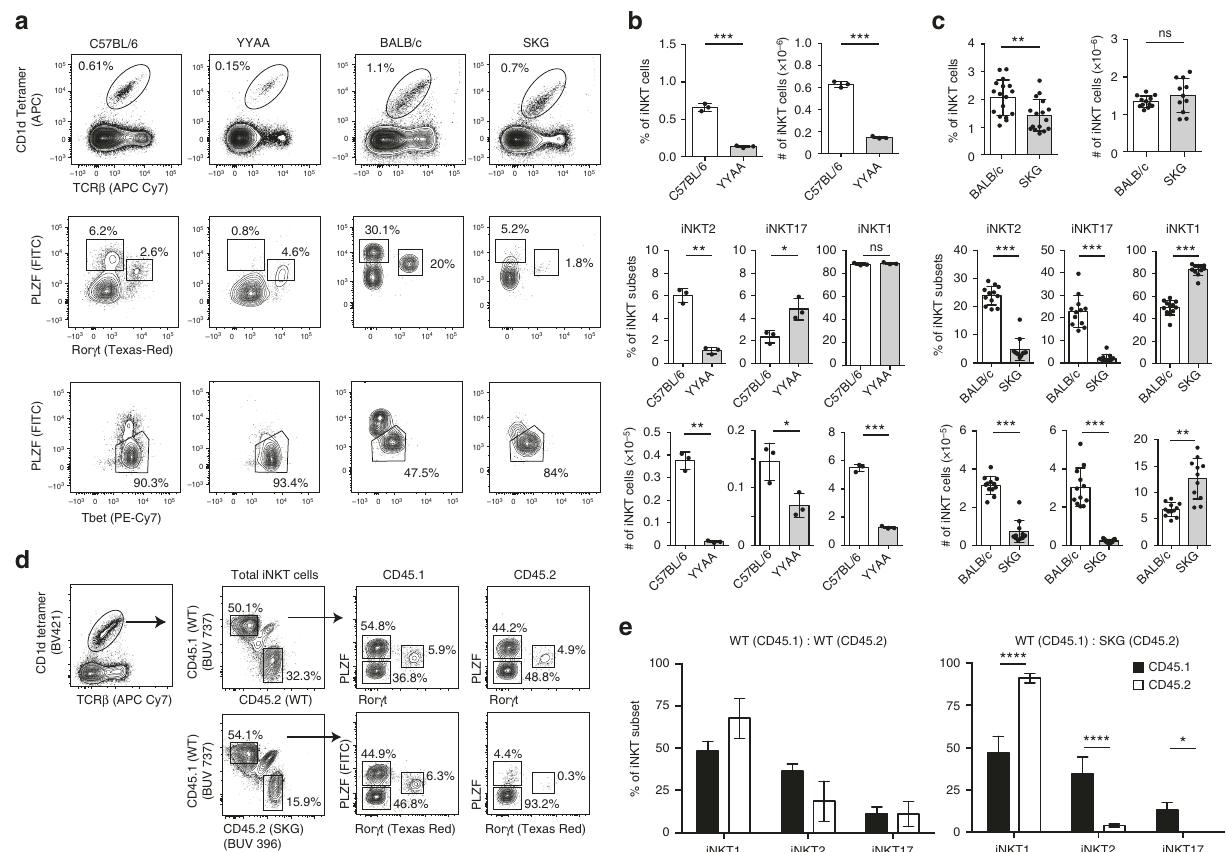
Fig. 4 Cell-intrinsic de fi ciency in iNKT2 and iNKT17 subsets development in mice with Zap70 hypomorphic mutations. a Representative fl ow cytometry plots showing the frequency of total iNKT cells and iNKT cell subsets in the thymi of 8-week-old C57BL/6, C57BL/6 YYAA, BALB/c, and BALB/c SKG mice. Each genotype was analyzed independently and compared to wild-type control mice of the appropriate background. b , c Summary of the data shown in a with percentages and cell numbers of total iNKT cells and iNKT cell subsets in the various genotypes analyzed. Data are mean ± SD. Signi fi cance was assessed using the unpaired t -test. d Analysis of thymic iNKT cell subsets in competitive bone marrow chimera. Congenically marked bone marrow cells from BALB/c wild-type mice (CD45.1) were mixed in a 1:1 ratio with (CD45.2) BALB/c or SKG bone marrow cells and injected into lethally irradiated F1 (CD45.2 × CD45.1) BALB/c mice. The thymi of the chimera were analyzed for iNKT cell subset composition 8 – 10 weeks post reconstitution and representative fl ow cytometry plots are shown. After gating on total iNKT cells, the proportion of iNKT cell subsets derived from either CD45.2 + or CD45.1 + bone marrow cells is shown. e Summary of the data shown in d with ≥ 5 mice per group. Data are represented as mean ± SD. Signi fi cance was assessed using one-way analysis of variance (ANOVA) * p < 0.05; ** p < 0.01; *** p < 0.001; **** p < 0.0001; ns, not signi fi ( Ifn γ , Tbx21 , Cxcr3 , Ccr5 , Il2rb , Fasl , Bcl2 , Il2 , Zbtb16 , Slamf6 , Il17rb , Il6ra , Ccr7 ) is different between subsets (Supplementary Figs. 5 and 6). For example, the chromatin landscapes of the Ifn γ and Tbx21 genes, encompassing not only their promoters but also intragenic and intergenic regions extending as far as several kilobases away, are clearly accessible in iNKT1 but not in iNKT2 cells. By contrast, the chromatin landscape surrounding the Zbtb16 (encoding PLZF), Slamf6 (encoding Ly108), Il17rb , Il6ra , and Ccr7 genes is clearly more accessible in iNKT2 than iNKT1 cells, in agreement with the differential expression of these genes between these two iNKT subsets 33 – 35 . Globally, 17,464 regions (out of a total of 90,051 accessible regulatory regions identi fi ed) are differentially accessible between BALB/c iNKT1 and iNKT2 cells (Fig. 7a). Similarly, 11,065 regions are differen- tially accessible between SKG iNKT1 and iNKT2 cells (Fig. 7c). Regions that are more accessible in BALB/c iNKT1 than in BALB/c iNKT2 cells also tend to be more accessible in SKG iNKT1 than in SKG iNKT2 cells (Fig. 7b, d). Conversely, the same holds true for regions that are more accessible in iNKT2 over iNKT1 cells (Fig. 7b, d). These results suggest that the mechanisms involved in setting up the chromatin accessibility